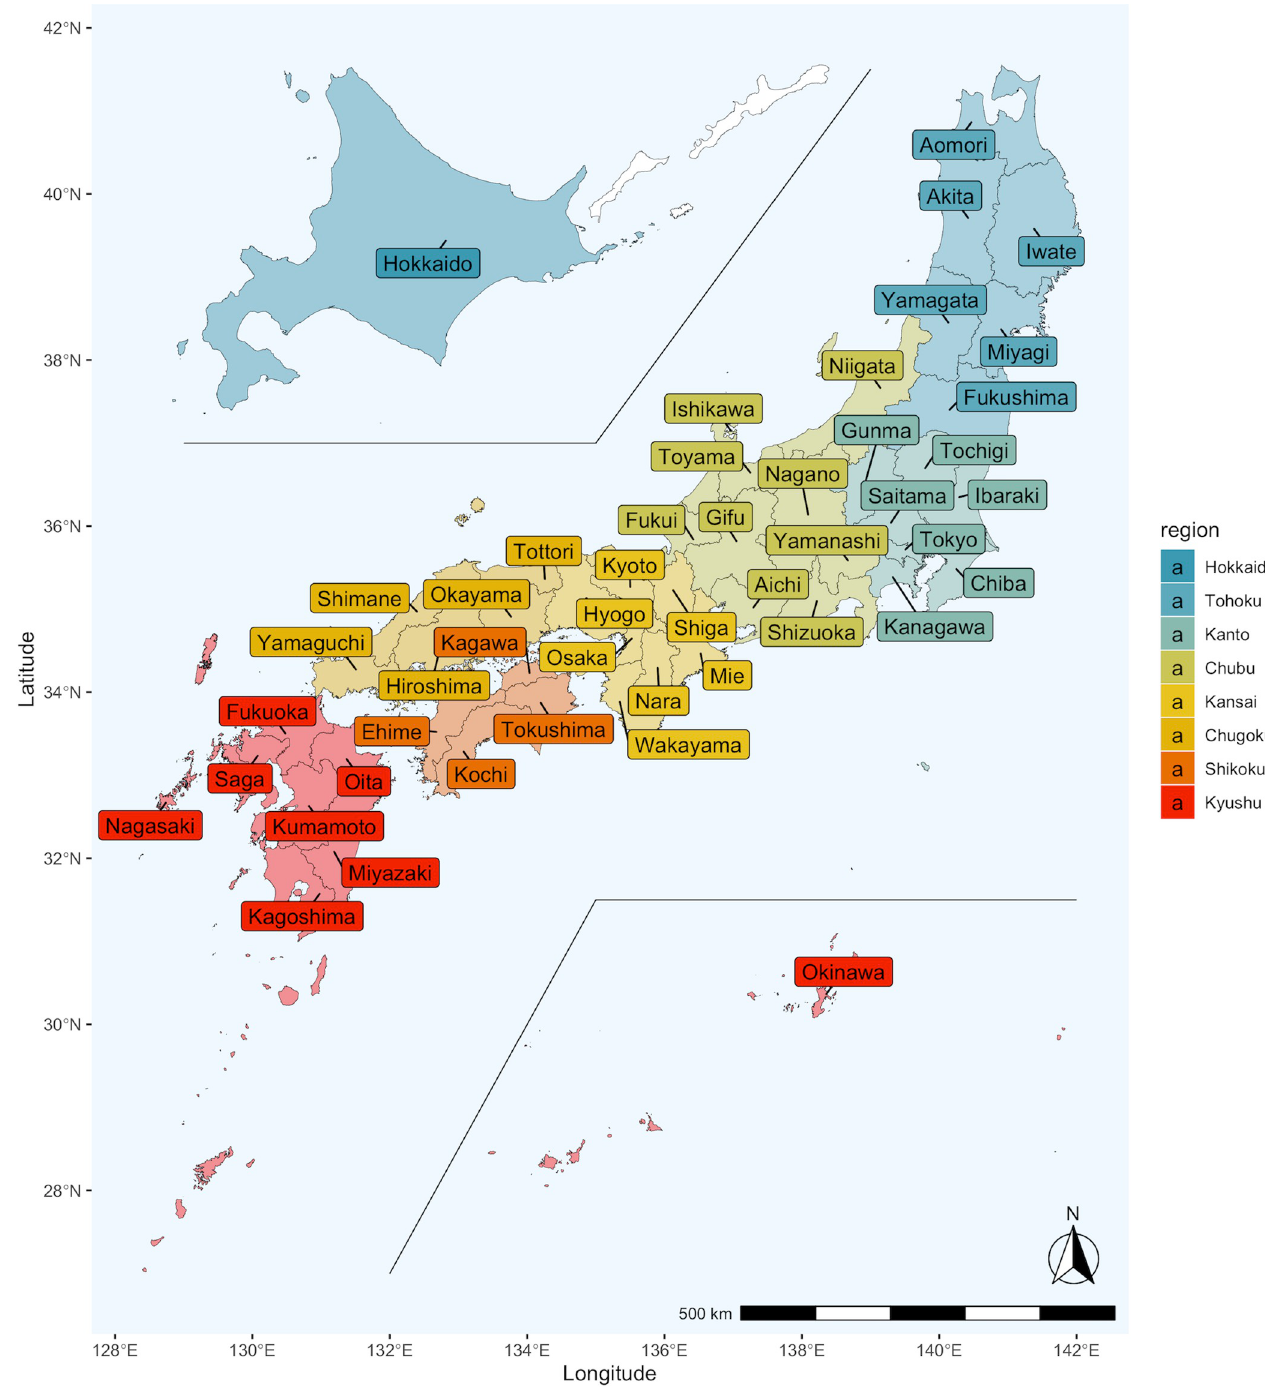
Fig 1. Map of Japan and prefectures. Japan has 47 prefectures divided into eight regions. These regions are not official administrative units but are used only for statistical and other purposes. The following map data (CC BY 4.0) was processed and used: Ministry of Land, Infrastructure, Transport and Tourism. National surveys of Japan—Administrative area data (in Japanese). 2019. Available from: https://nlftp.mlit.go.jp/ksj/gml/datalist/KsjTmplt-N03-v3_0.html.